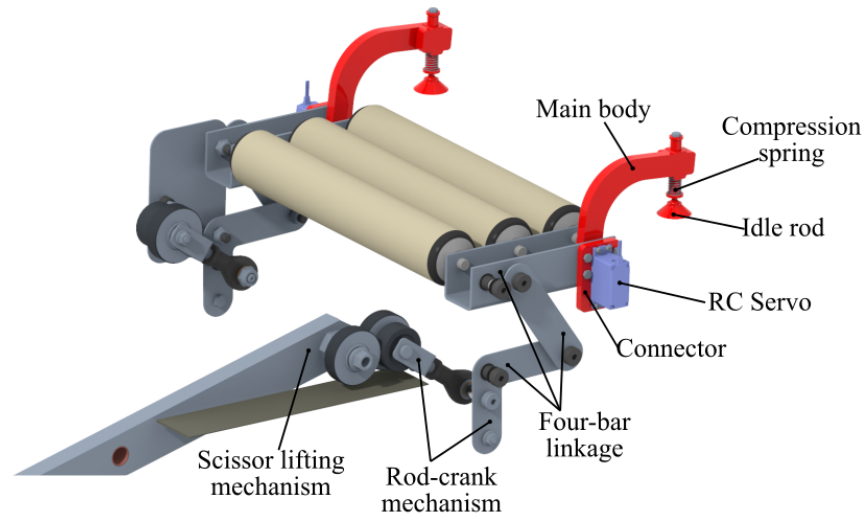
Figure 3. Swivel-hatch mechanism equipped with rotating